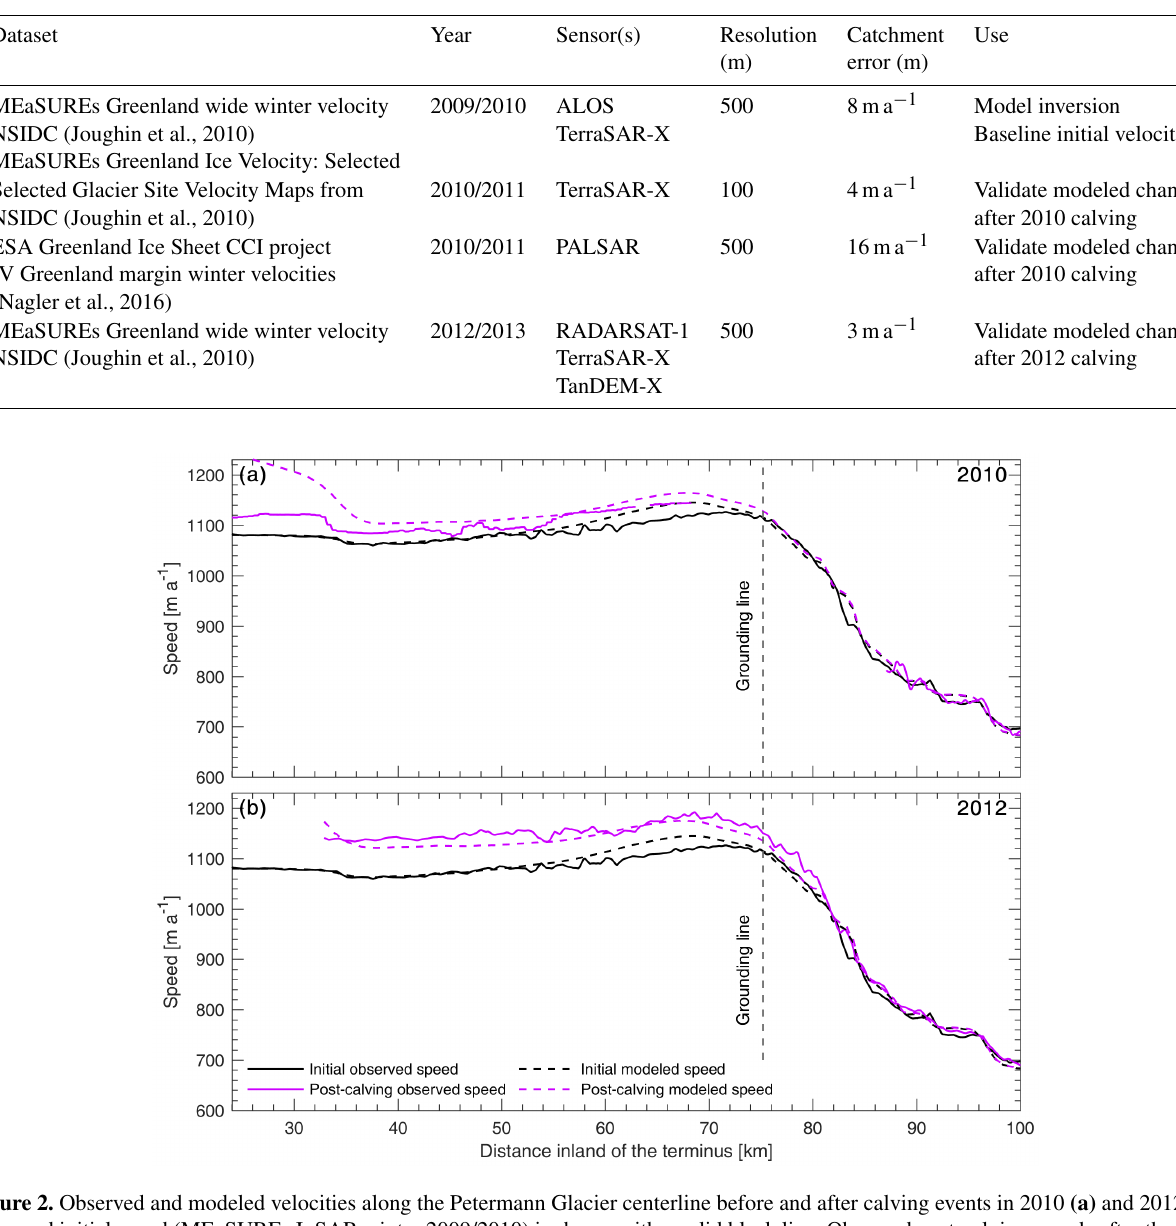
Table 1. Velocity data sources for Petermann Glacier.